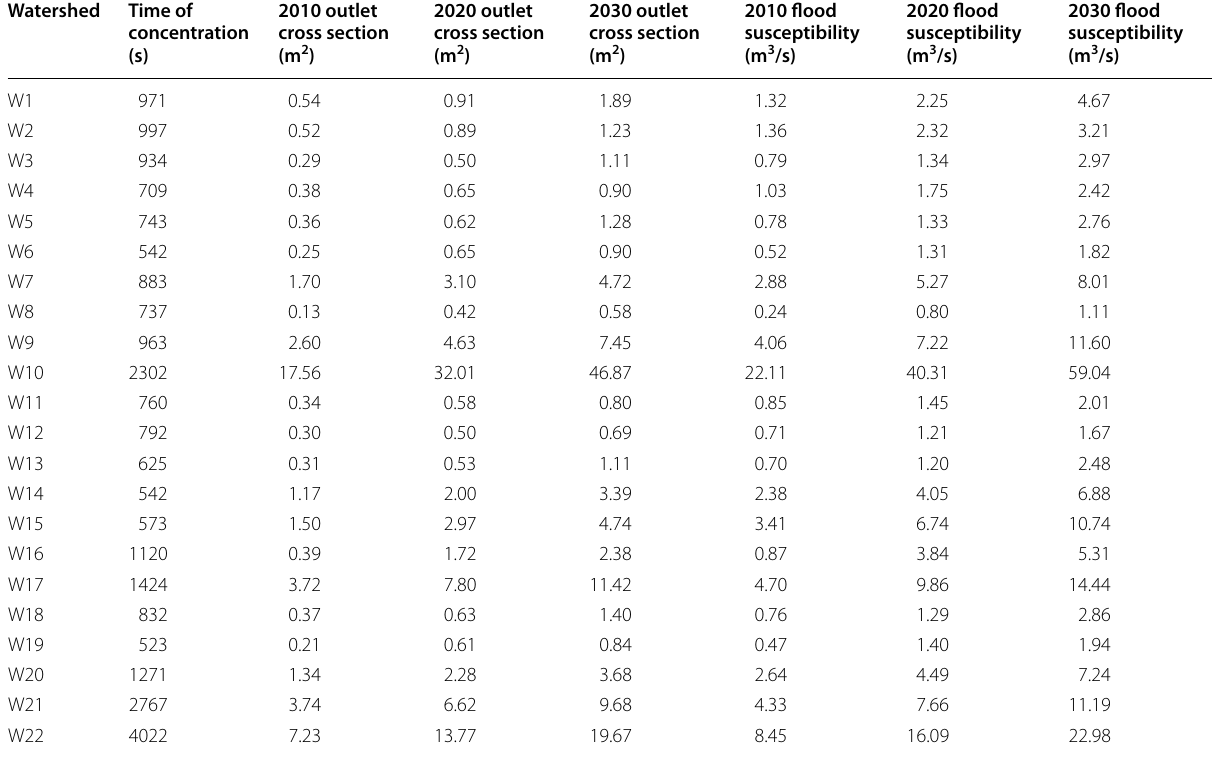
Table 5 Time of concentration, outlet cross-section, and flood susceptibility of the watersheds within three periods of 2010, 2020, and